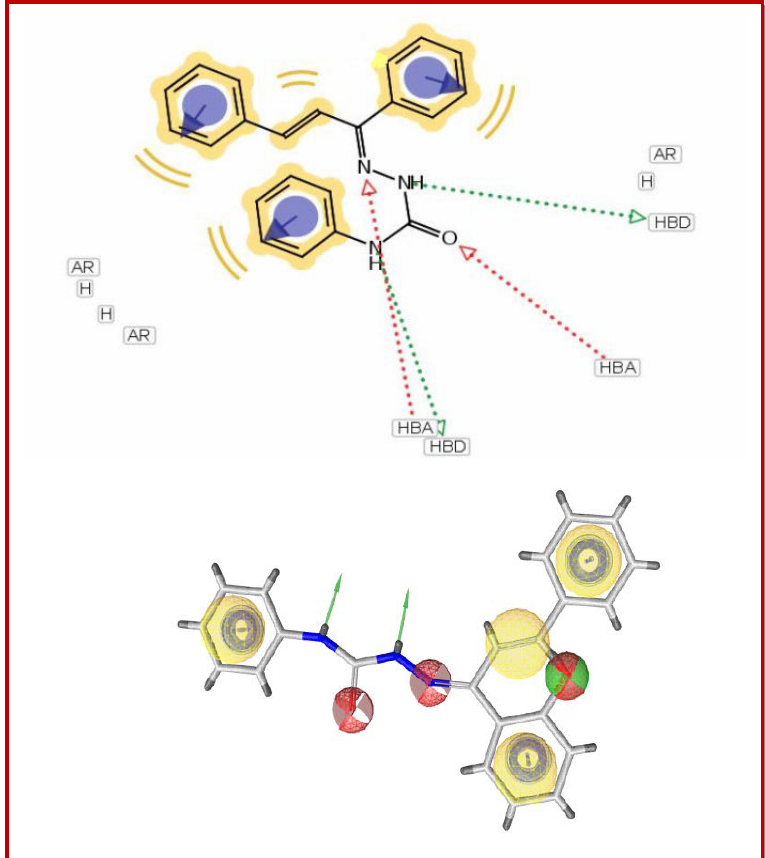
Figure 1: Pharmacophore of the designed chalconesemicarbazone by ligandscout 2.02